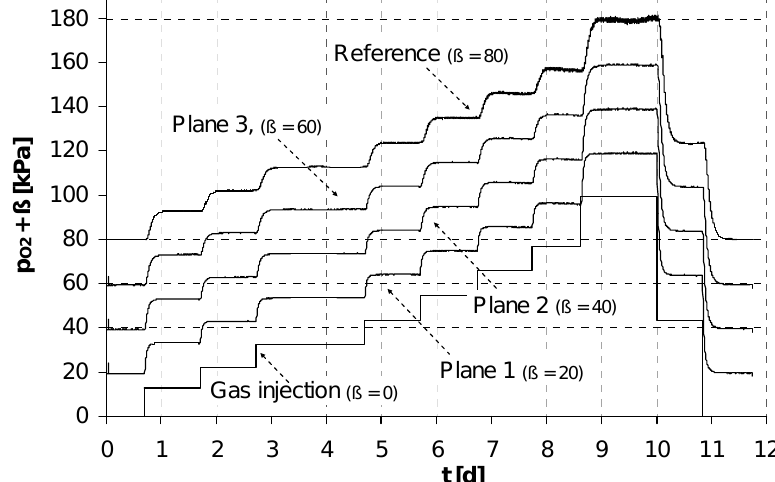
mixed with N (top) and p mixed with air (bottom) by the Figure 2. Detection of p O 2 2 CO 2 individual monitoring planes for a stepwise gas injection. For better readability the records of the different monitoring planes were separated by